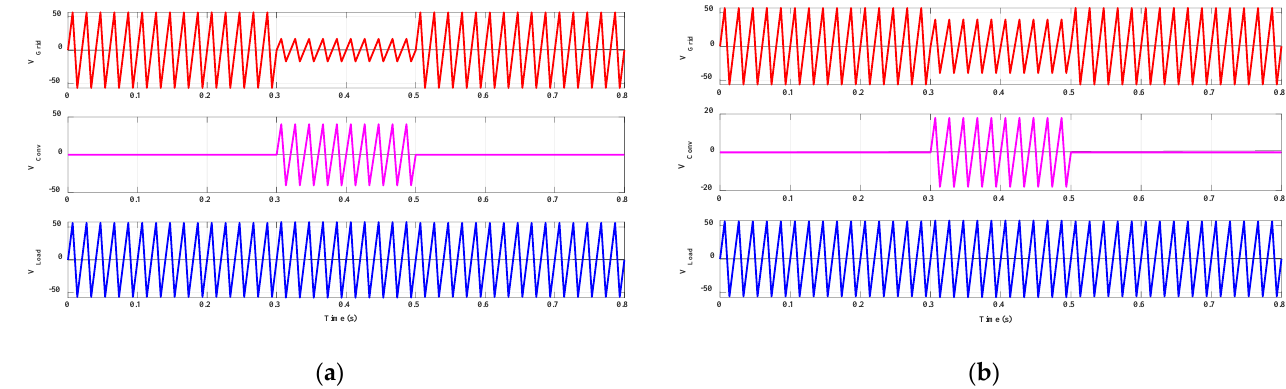
Figure 13. Computer simulation results for the compensation of voltage sag for depth level of ( a ) 70% and ( b ) 30%.